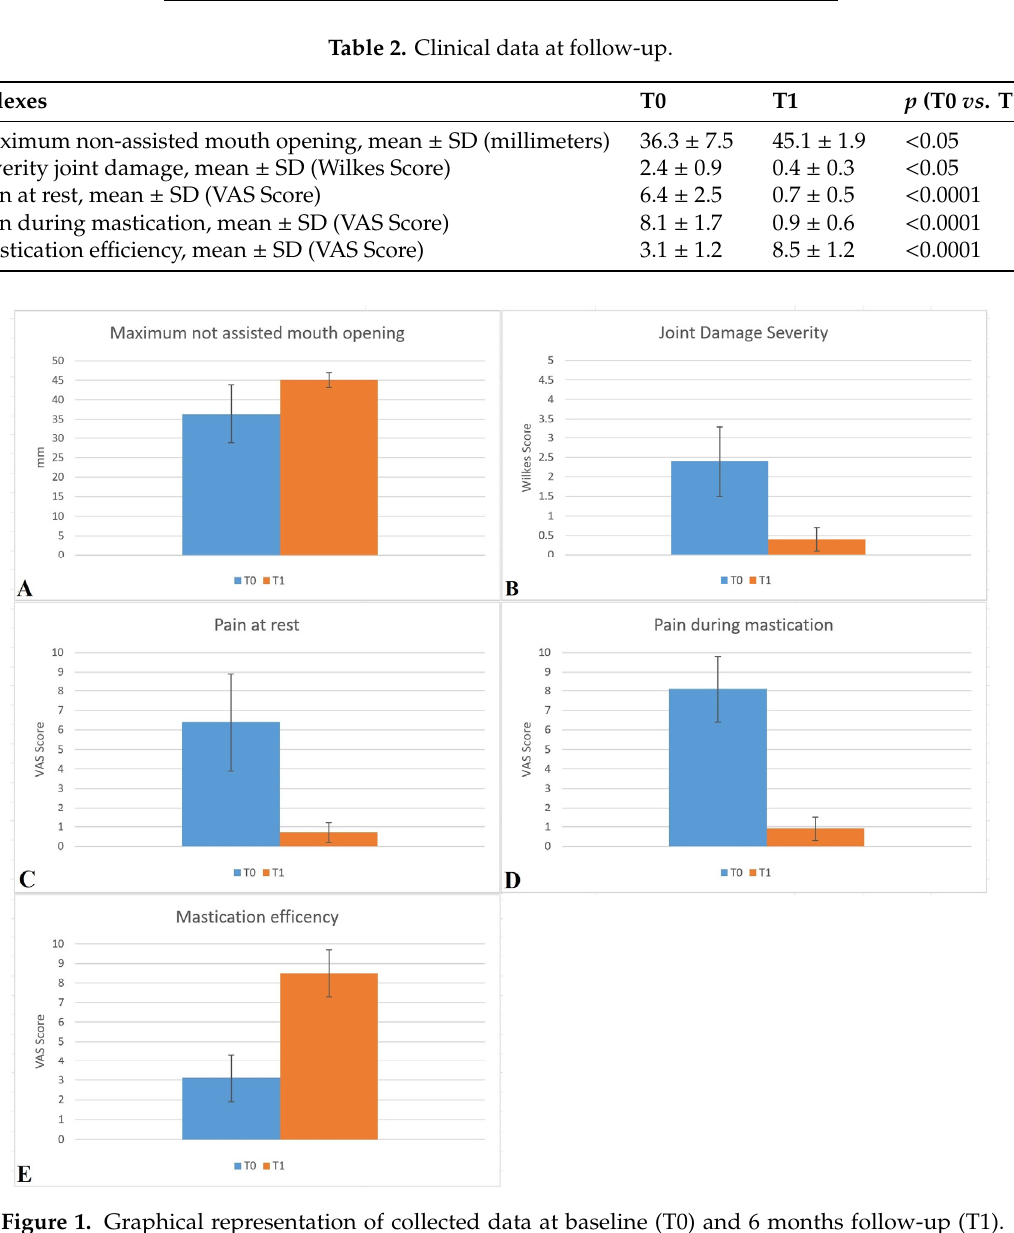
Figure 1. Graphical representation of collected data at baseline (T0) and 6 months follow-up (T1). (A) Maximum non-assisted mouth opening in mm. (B) Joint damage severity expressed in Wilkes Score. (C) Pain at rest expressed in the Visual Analogic Scale (VAS) Score. (D) Pain during mastication expressed in VAS Score. (E) Masticatory efficiency expressed in VAS Score.